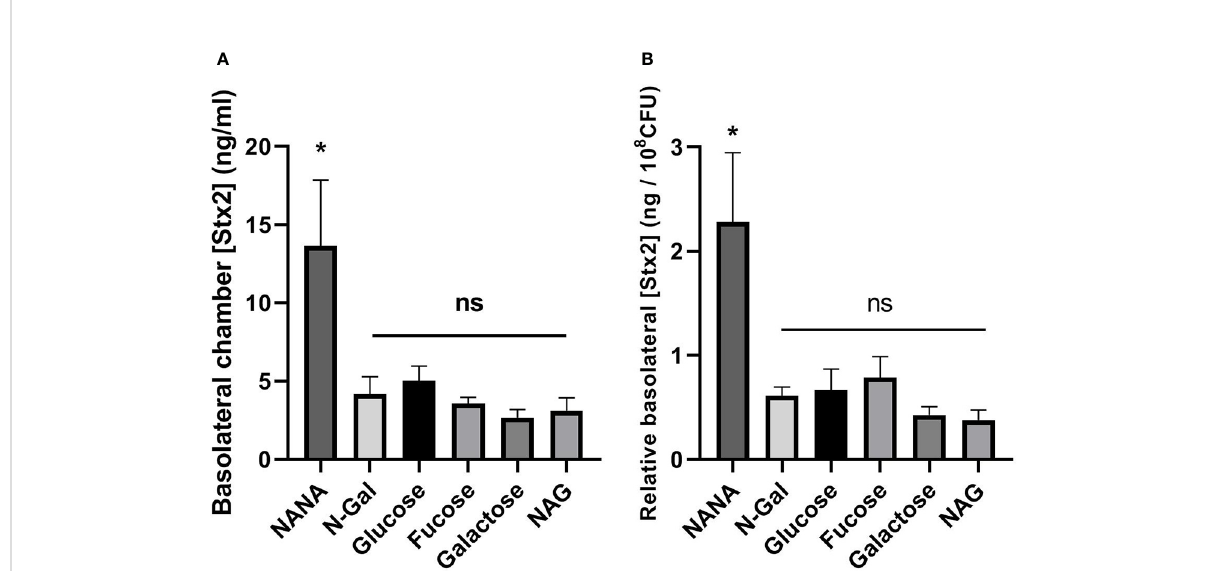
FIGURE 4 Translocation of Stx2 across the HCT-8 monolayer. E. coli O157:H7 D stx2 cultures + 100 ng/ml Stx2 supplemented with 10 mM Fucose, Galactose, N-Gal. NANA, NAG or Glucose were coincubated with HCT-8 monolayers grown on Milicell supports in M9 medium at 37°C for 5 h in a humidi fi ed 5% CO 2 incubator. (A) Stx2 concentration (basolateral chamber) measured by Vero cell cytotoxicity assays. (B) Translocated Stx2 concentration (basolateral chamber) relative to the bacterial density found in the apical chamber after incubation, expressed as ng of Stx2 per